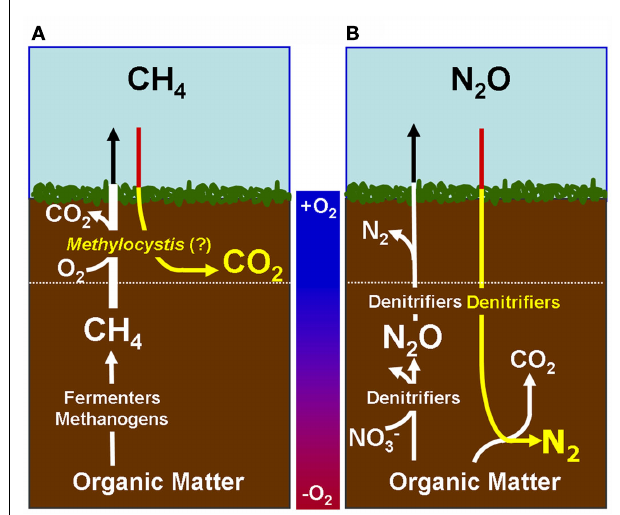
FIGURE 1 | Proposed Model of Microbes that are responsible of atmospheric sink function of CH 4 and N 2 O in natural wetlands. The quantitative contribution to global net fluxes of CH 4 and N 2 O into the atmosphere has not been evaluated in acidic wetlands. (A) Acidic wetland covered by Sphagnum plants with low nitrogen input and mineralization rates.White Pathway: Plant-derived organic matter is degraded by microbial fermentation, acetogenesis, and methanogenesis to CH 4 that is transported to oxygen-saturated zones close to the surface.The thickness of the oxygen-saturated layer is dependent of water table level (white dotted line). Methanotrophs (such as Methylocystyceae, Beijerinkiaceae, but as well Methylococcaceae) consume up to 90% of methanogenic CH 4. Products are microbial biomass and CO 2 .The not-consumed proportion of CH 4 is released into the atmosphere. Methanotrophs convert CH 4 to carbon dioxide (CO 2 ) which is released into the atmosphere.Yellow pathway: Methylocystis species likely consume atmospheric CH 4 when CH 4 supply from anoxic zones is limited. (B) Natural wetland with high nitrogen input and mineralization rates (e.g., minerotrophic fens, Palsa peats).White pathway: In nitrogen-rich acidic wetlands (e.g., Palsa peats) a part of anaerobic organic matter degradation intermediates are consumed by denitrifiers that reduce NO − to N 2 O and N 2 . N 2 O and N 2 is released into the 3 atmosphere. Ammonia-oxidizing bacteria (AOB) are known to produce small amounts of N 2 O during oxidation of ammonia (Schmidt et al., 2004; Braker and Conrad, 2011).Yellow pathway: Under as-yet unresolved environmental conditions atmospheric N 2 O may be further reduced to N 2 by to date not cultured denitrifiers that use electrons from organic